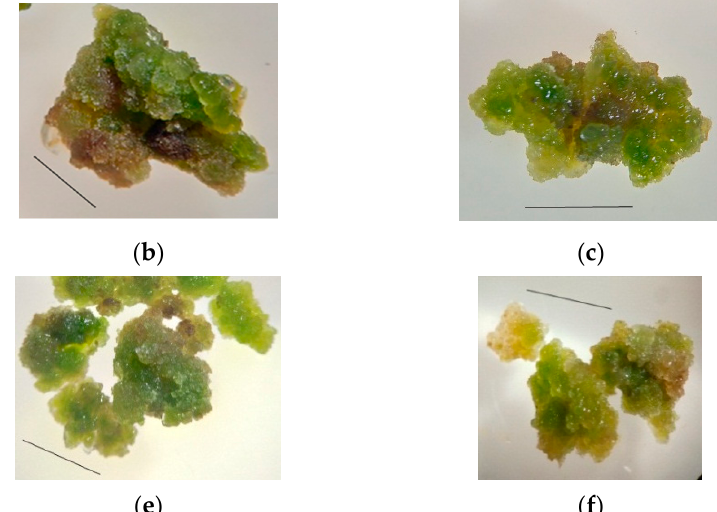
Figure 3. Changes in the appearance of S. hortensis callus tissue over six subcultures: ( a ) 1st subculture, ( b ) 2nd subculture, ( c ) 3rd subculture, ( d ) 4th subculture, ( e ) 5th subculture, and ( f ) 6th subculture. Bars—0.5 cm.